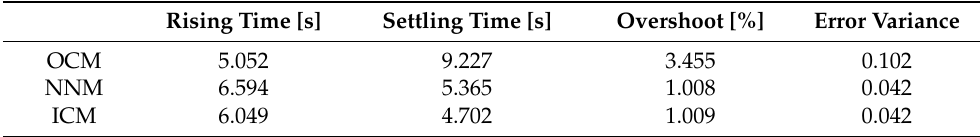
Table 6. Tracking performance indexes of three control